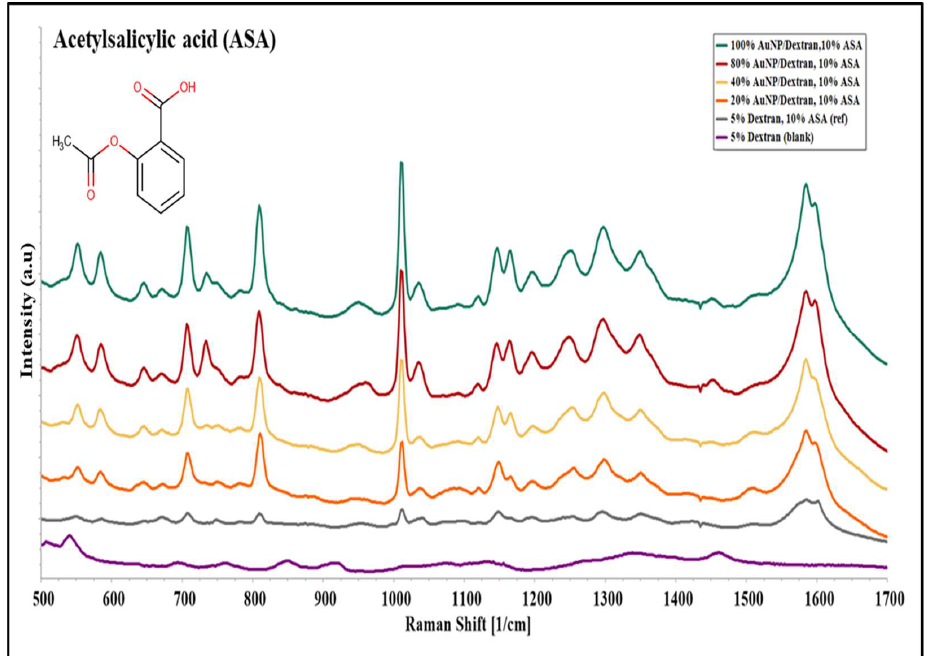
Figure 3. SERS spectra of 10% acetylsalicylic acid (ASA) prepared in Au/dextran NP solutions of 20–100% concentrations; 10% ASA in 5% Dextran was used as a reference, and 5% Dextran solution was used as a blank. Spectra were acquired on a BW Tek Raman microscope.